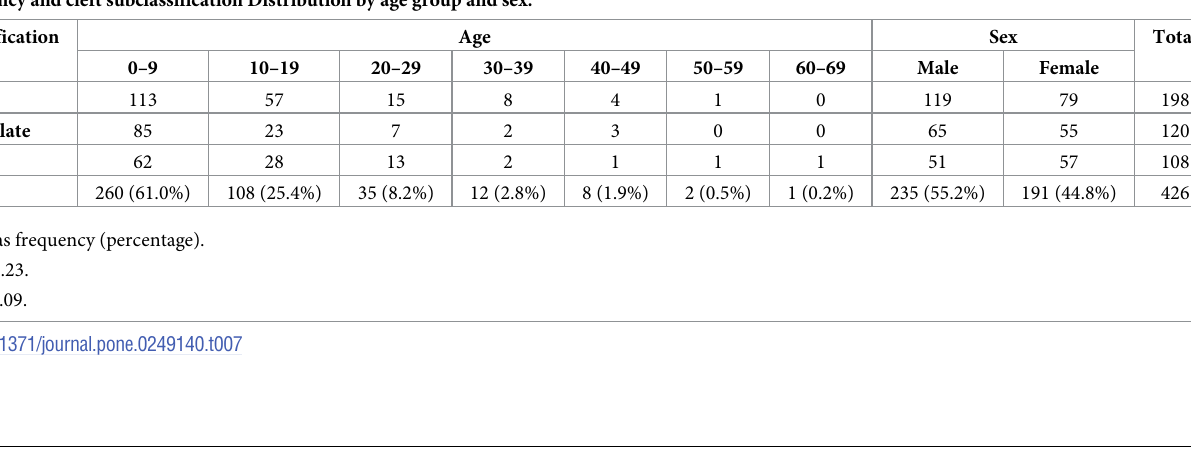
Table 7. Frequency and cleft subclassification Distribution by age group and